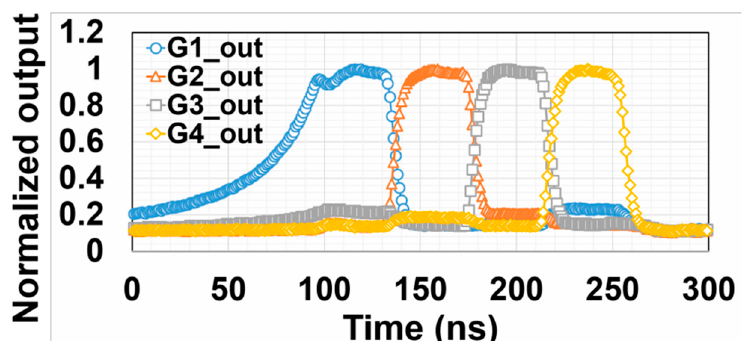
Figure 4. Modulation characteristic with a short pulse laser of 930 nm